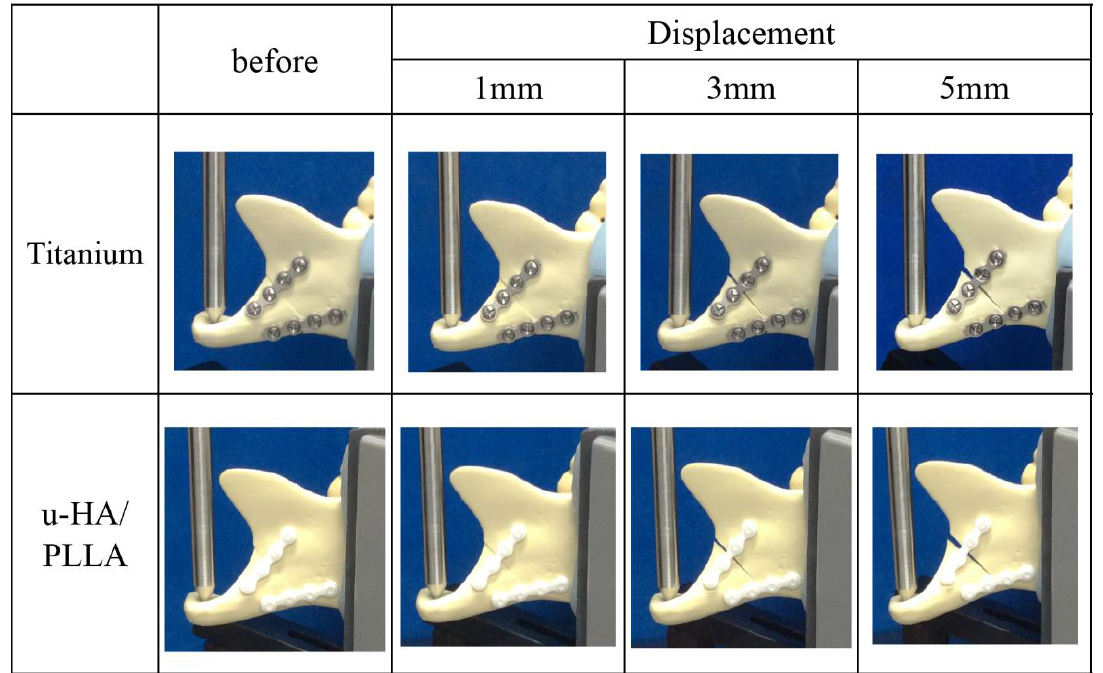
Figure 5. Change in subcondylar fracture segments under anteroposterior loading. Ti, titanium (plates); u-HA/PLLA, unsintered hydroxyapatite/poly- L -lactide (bioresorbable plates).